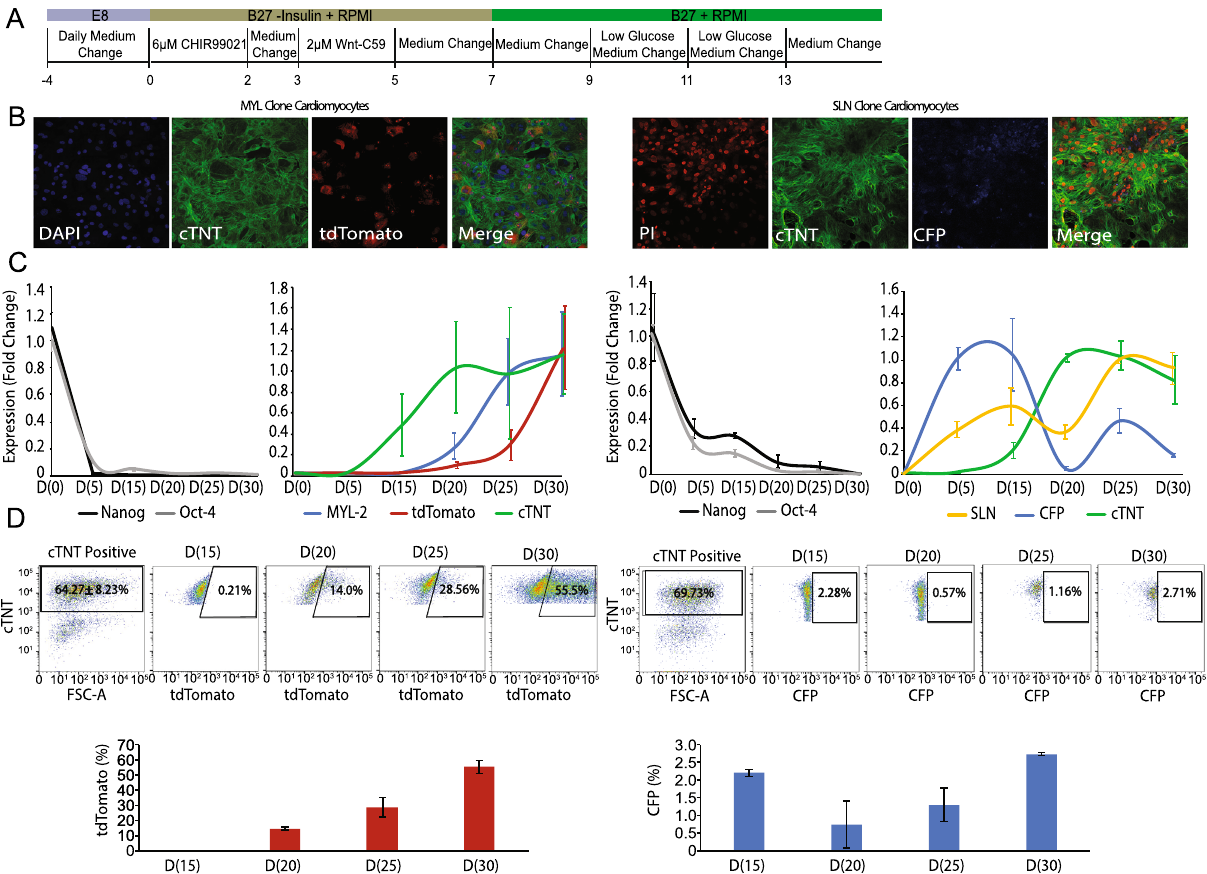
Figure 2. Cardiomyocyte directed differentiation of human iPSC reporter lines. ( A ) Schematic of the cardiomyocyte differentiation protocol 2 . ( B ) Representative Immunofluorescence stainings performed on day 30 cardiomyocytes for both the MYL-2/tdTomato and SLN/eCFP reporters (left to right: nuclear stain (Blue/ Red), cTNT (green), fluorescence from reporter (tdTomato, eCFP), and merge). ( C ) Real-time PCR of MYL-2 and SLN reporters over a 30 day duration (increments of 5 days) for pluripotent markers (Nanog and Oct-4), cardiac specific genes (cTNT, MYL-2 and SLN), and respective fluorophores (tdTomato and eCFP) (n = 6). ( D ) Representative flow cytometry plots and corresponding bar graphs from day 15 to day 30 (increments of 5 days) cardiomyocytes depicting the tdTomato(+) and eCFP(+) population (%) within the cTNT(+) population respectively (n =